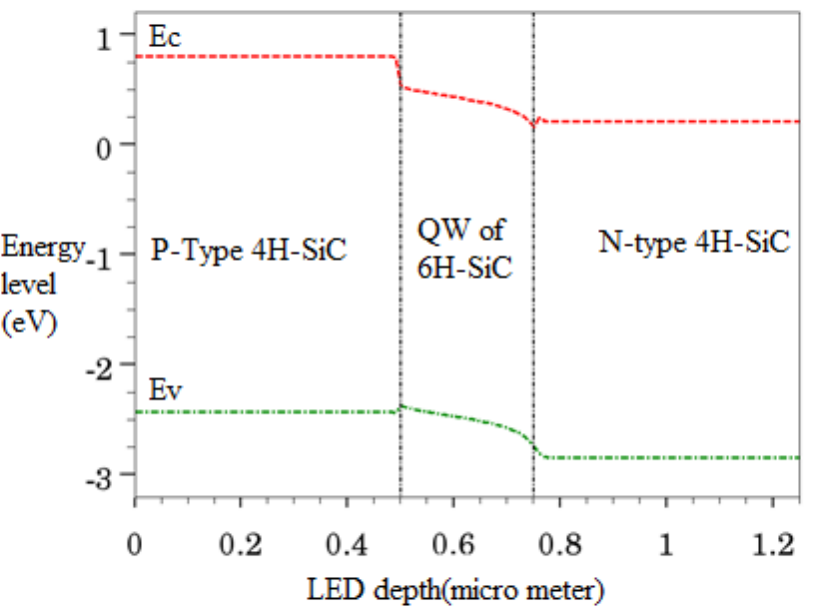
Figure 5. Energy band profile of SQW SiC LED as a function of its depth.